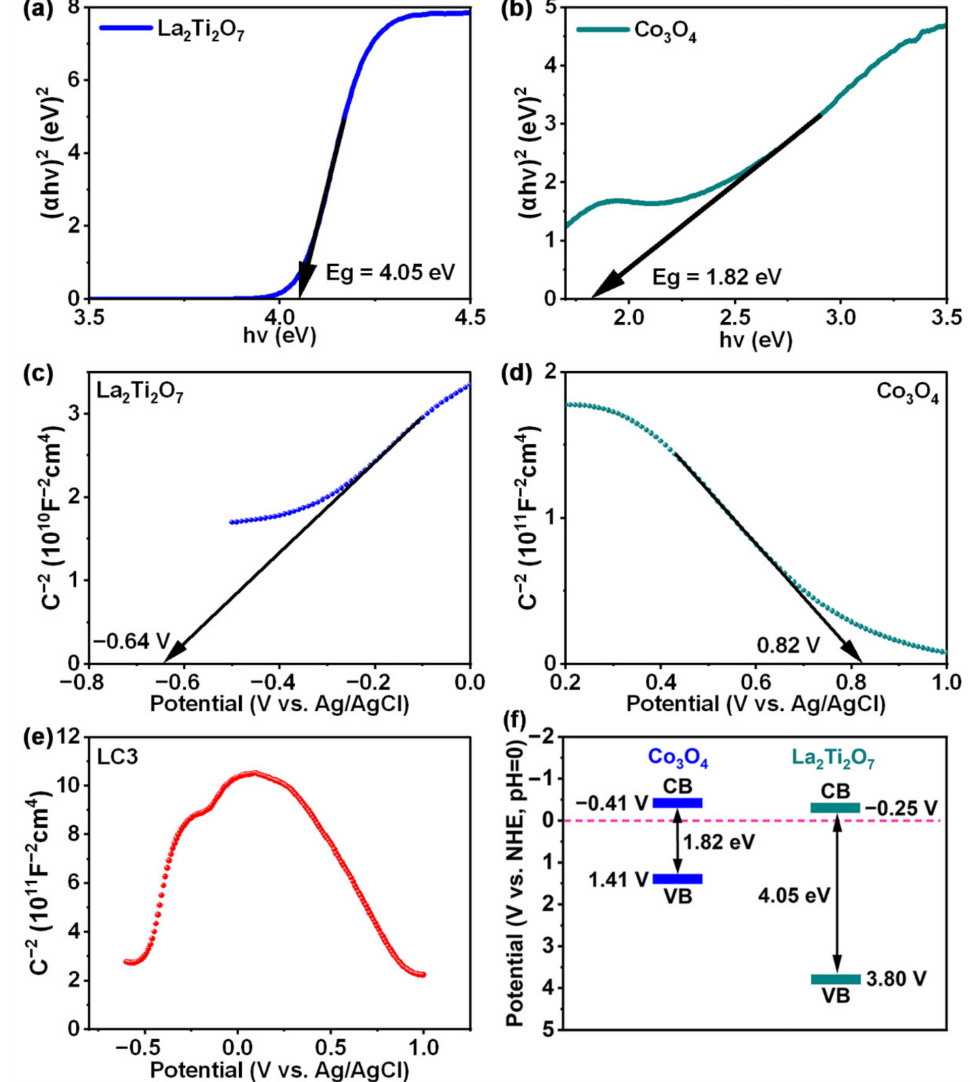
Figure 8. ( a ) Tauc plot of La 2 Ti 2 O 7 ; ( b ) Tauc plot of Co 3 O 4 ; ( c ) Mott-Schottky curve of La 2 Ti 2 O 7 ; ( d ) Mott-Schottky curve of Co 3 O 4 ; ( e ) Mott-Schottky curve of LC3; ( f ) Schematic diagram of energy band structure of Co 3 O 4 and La 2 Ti 2 O 7